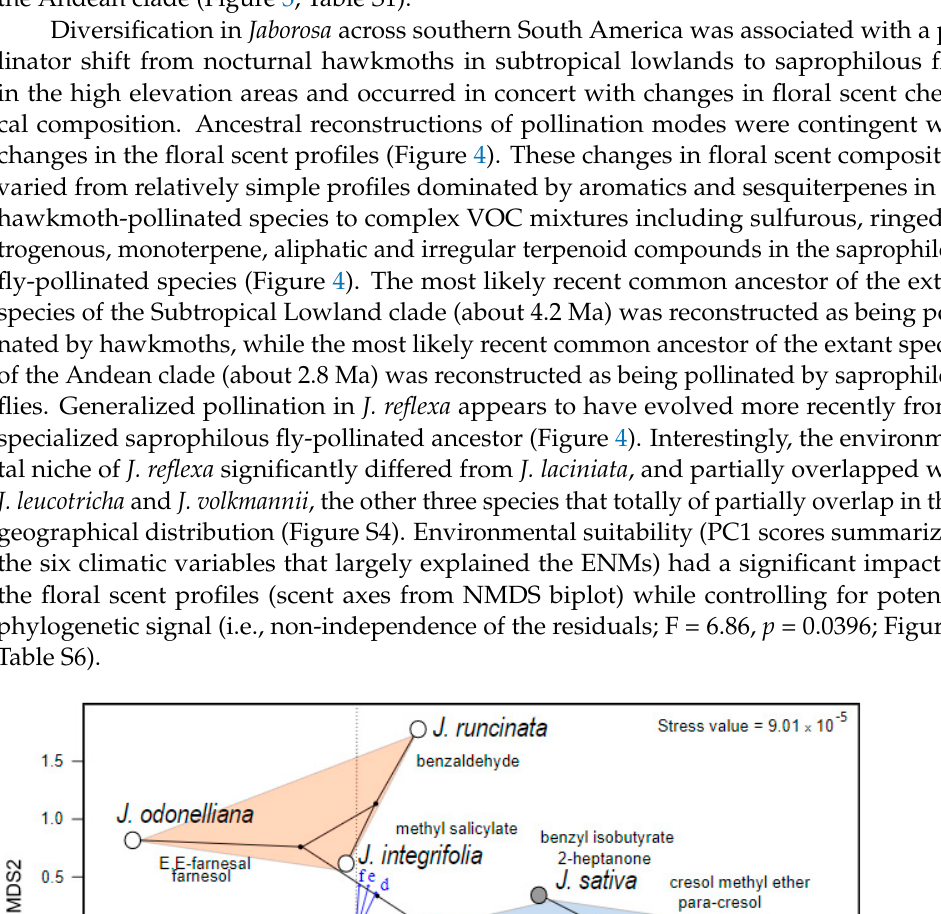
Figure 4. Reconstruction of floral scent and pollination mode in Jaborosa Juss. Phylogenetic rela- tionships among the eight Jaborosa species were projected in the space defined by floral scent pro- file; y-axis: NMDS1 (above) and NMDS2 (below) scores from Figure 3; x-axis: divergence time. Pie charts on each node show the posterior probability of each pollination mode (nocturnal hawk- moths in green, generalist by small insects in yellow and saprophilous flies in black) retrieved by